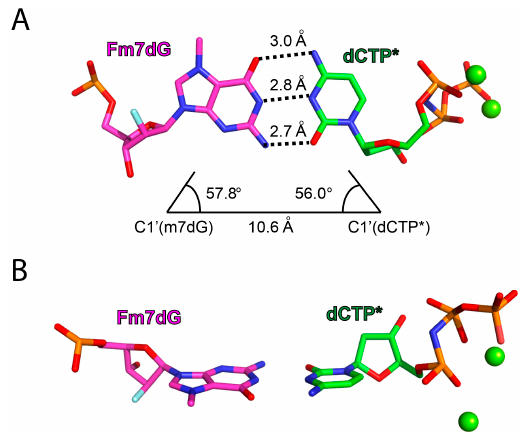
Figure 7. Base-pairing properties of Fm7dG and dCTP* in the replicating base pair site of pol η . ( A ) Watson–Crick base pairing of Fm7dG:dCTP*. The interbase hydrogen bonds are indicated with dotted lines. The λ angles and C1 ′ –C1 ′ distance for Fm7dG:dCTP* are shown. ( B ) Side view of Fm7dG:dCTP* with a coplanar base pair conformation.